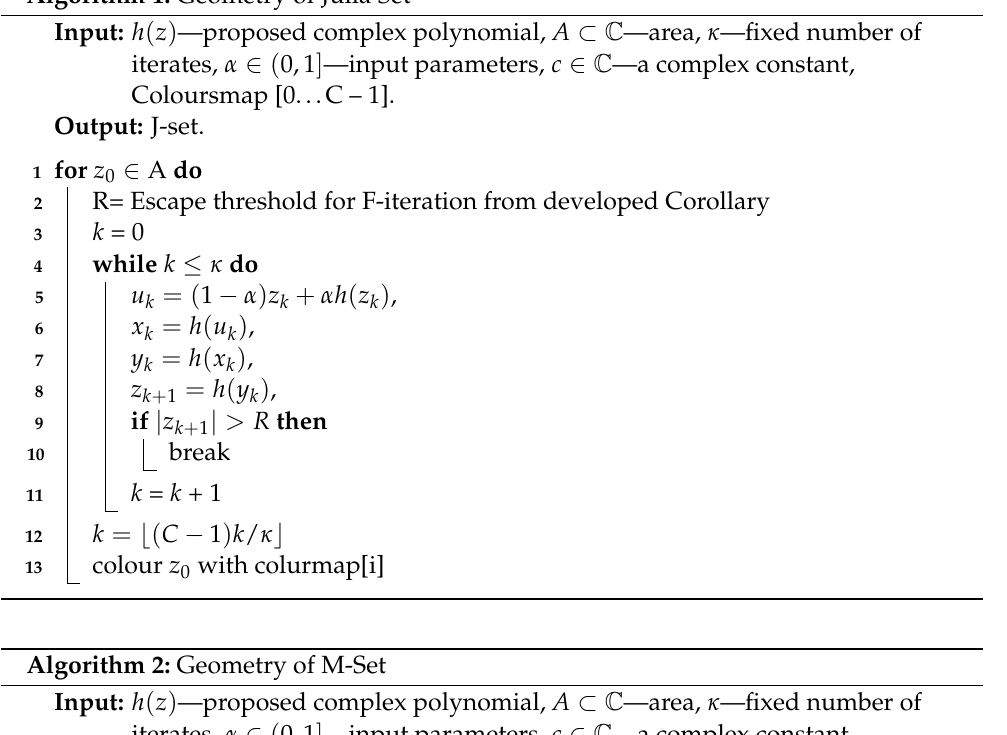
Algorithm 1: Geometry of Julia Set